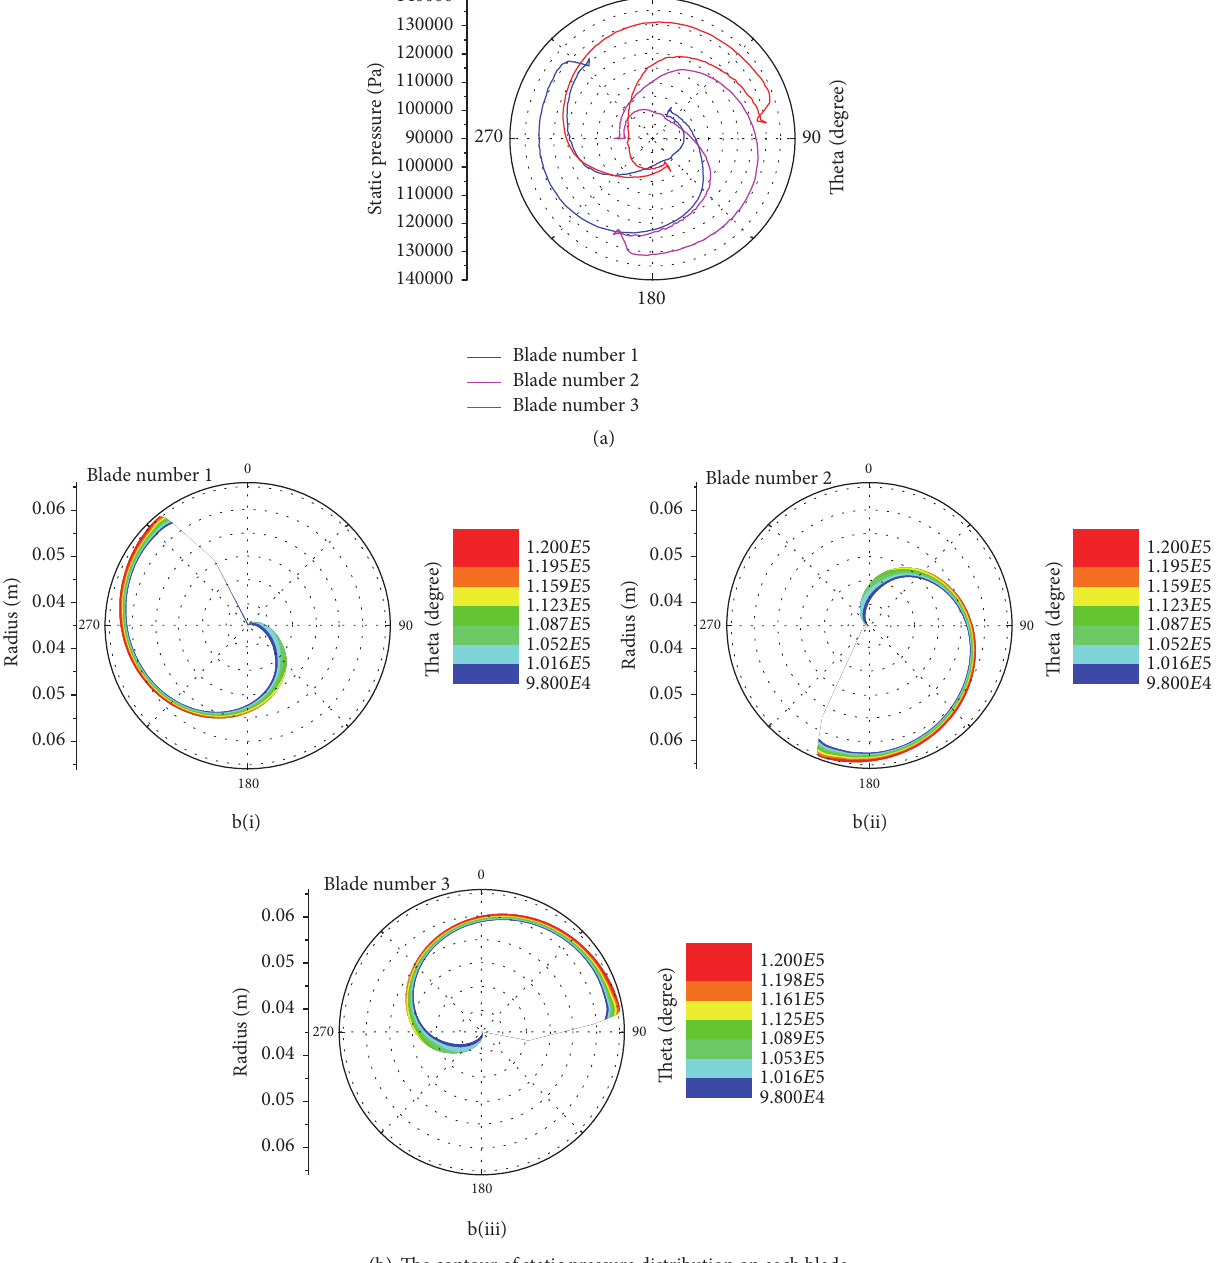
(b) The contour of static pressure distribution on each blade Figure 10: Static pressure distributions and pressure load on the blades of the inducer at 1.1 𝑄 𝑑